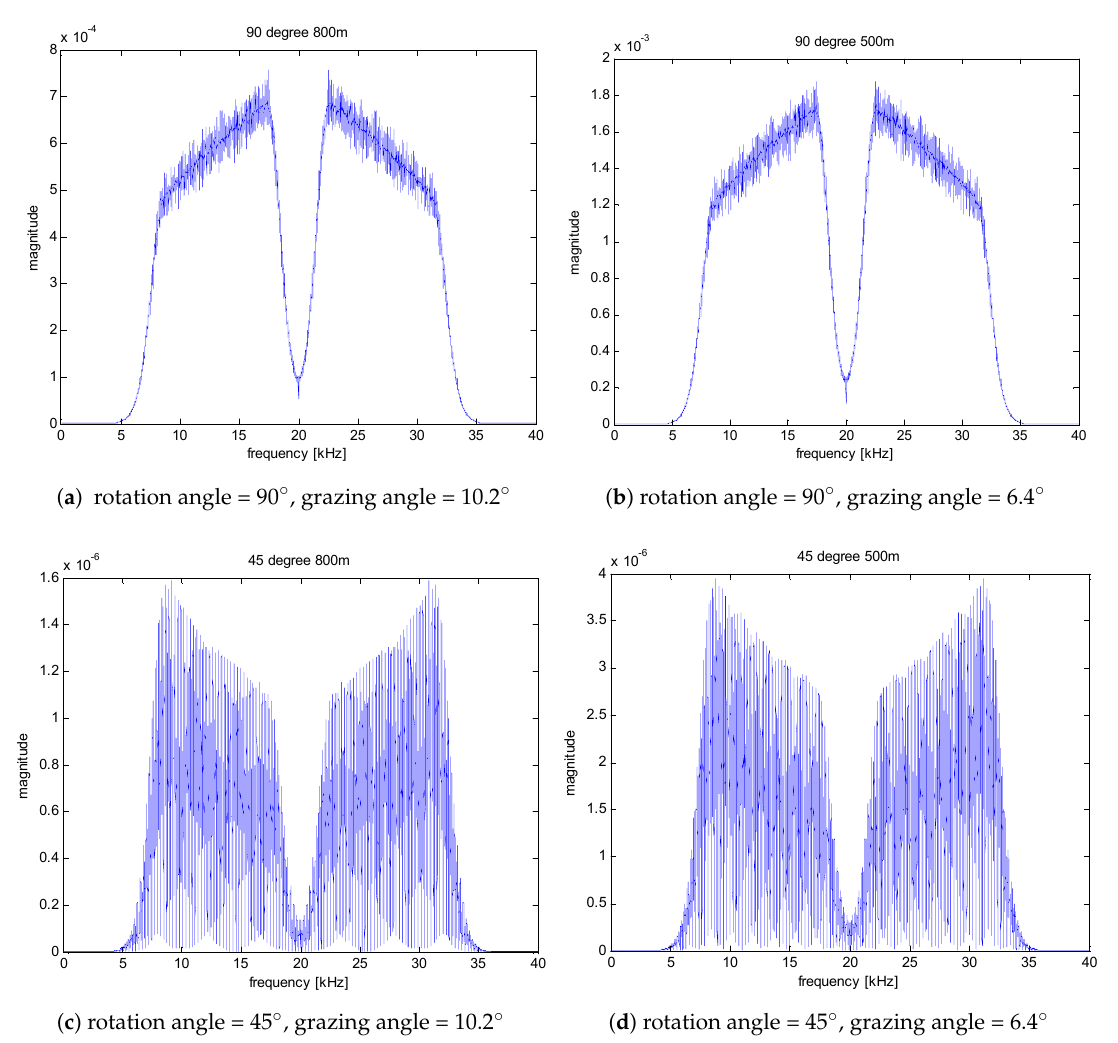
Figure 5. Magnitude spectra of the target responses for two grazing angles and two rotation